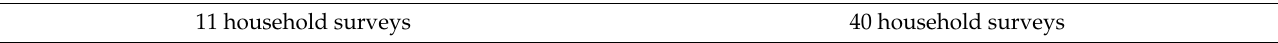
Table 1. Research activities undertaken for each end-user group. Rural